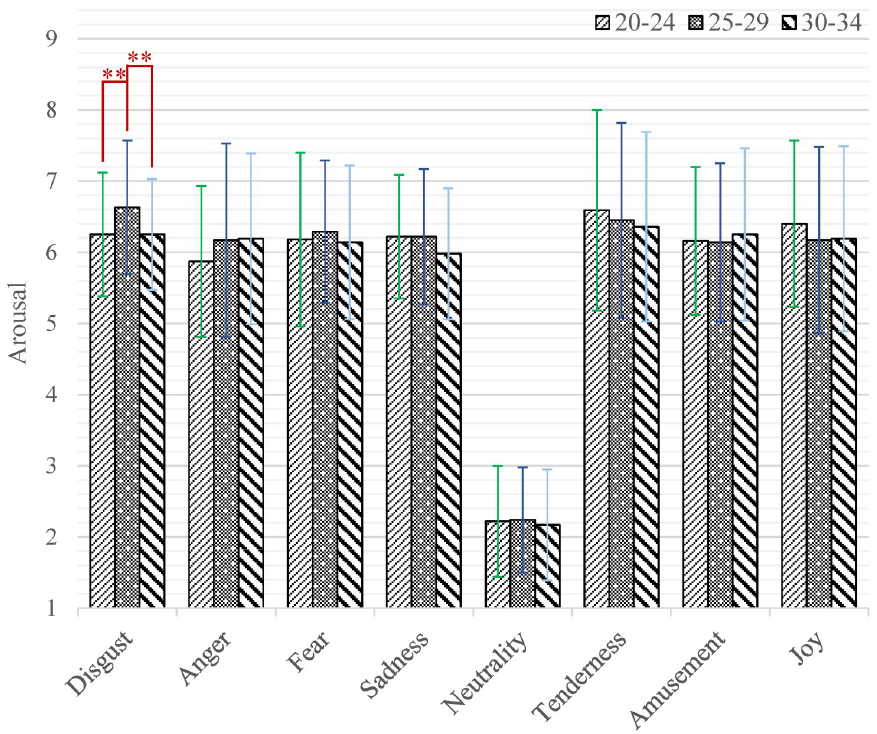
Fig 5. The arousal scores of each category of emotion-inducing short videos among participants with different ages. Statistical significance: * p < 0.05, ** p < 0.01, *** p < 0.001. Unless marked with the asterisk, no significant differences between these groups were